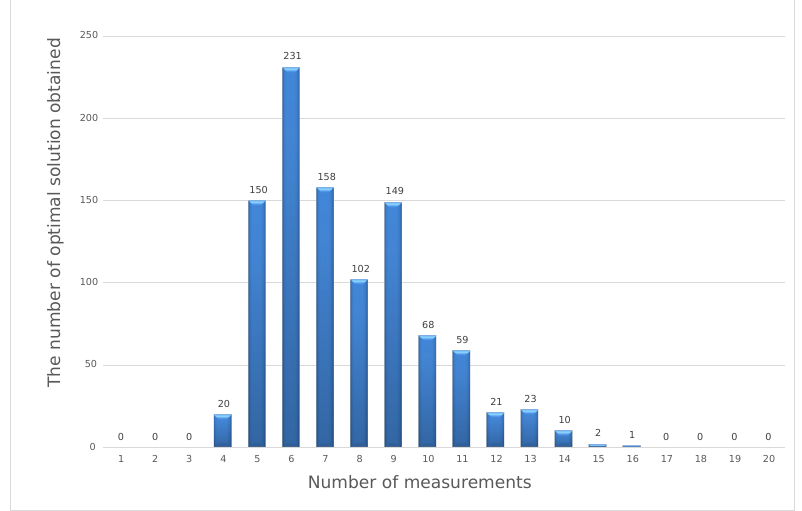
Figure 4. Optimal solutions in the weighted criteria method for a simulated series of 1000 sets of input data.